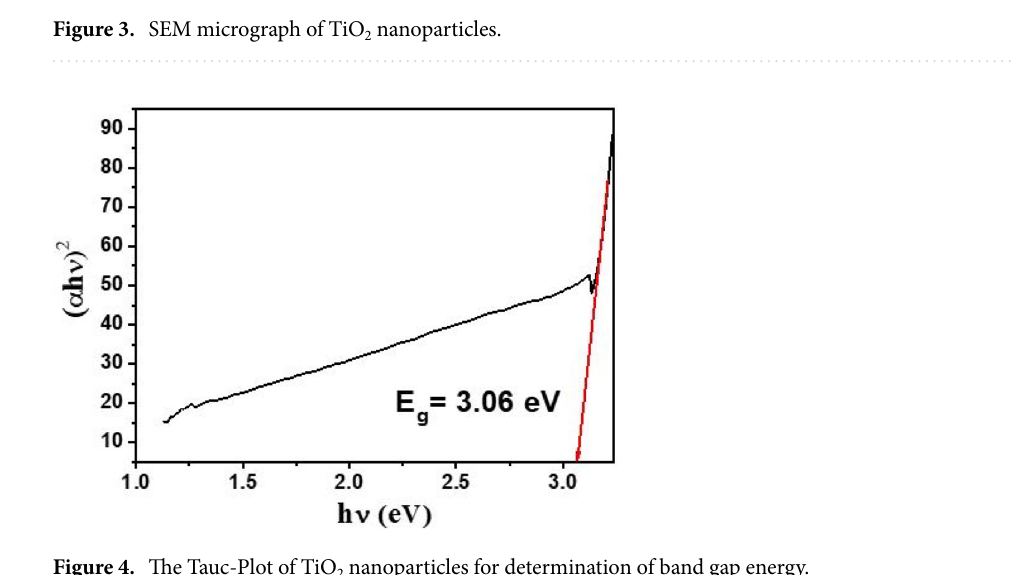
Figure 4. The Tauc-Plot of TiO 2 nanoparticles for determination of band gap energy.